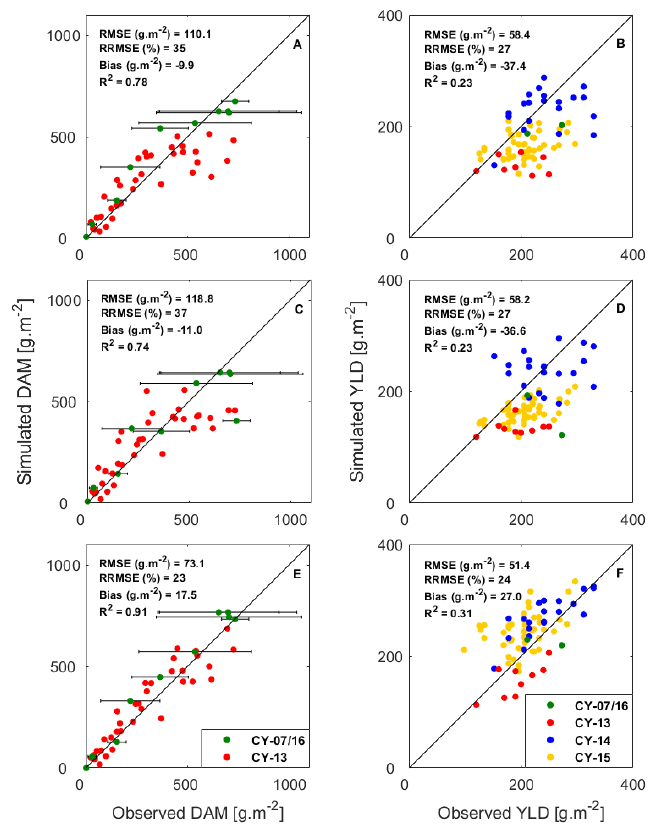
Figure 8. Scatter plots of simulated and observed DAM (left) and YLD (right) obtained with the SAFYE ‐ CO 2GSM (A,B), SAFYE ‐ CO 2SG (C,D), and SAFY ‐ CO 2 (E,F) model.